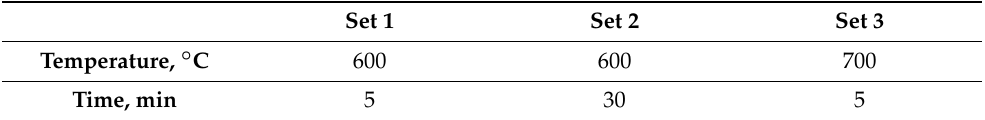
Table 2. Time and temperature for heat treatment of cold-rolled samples.